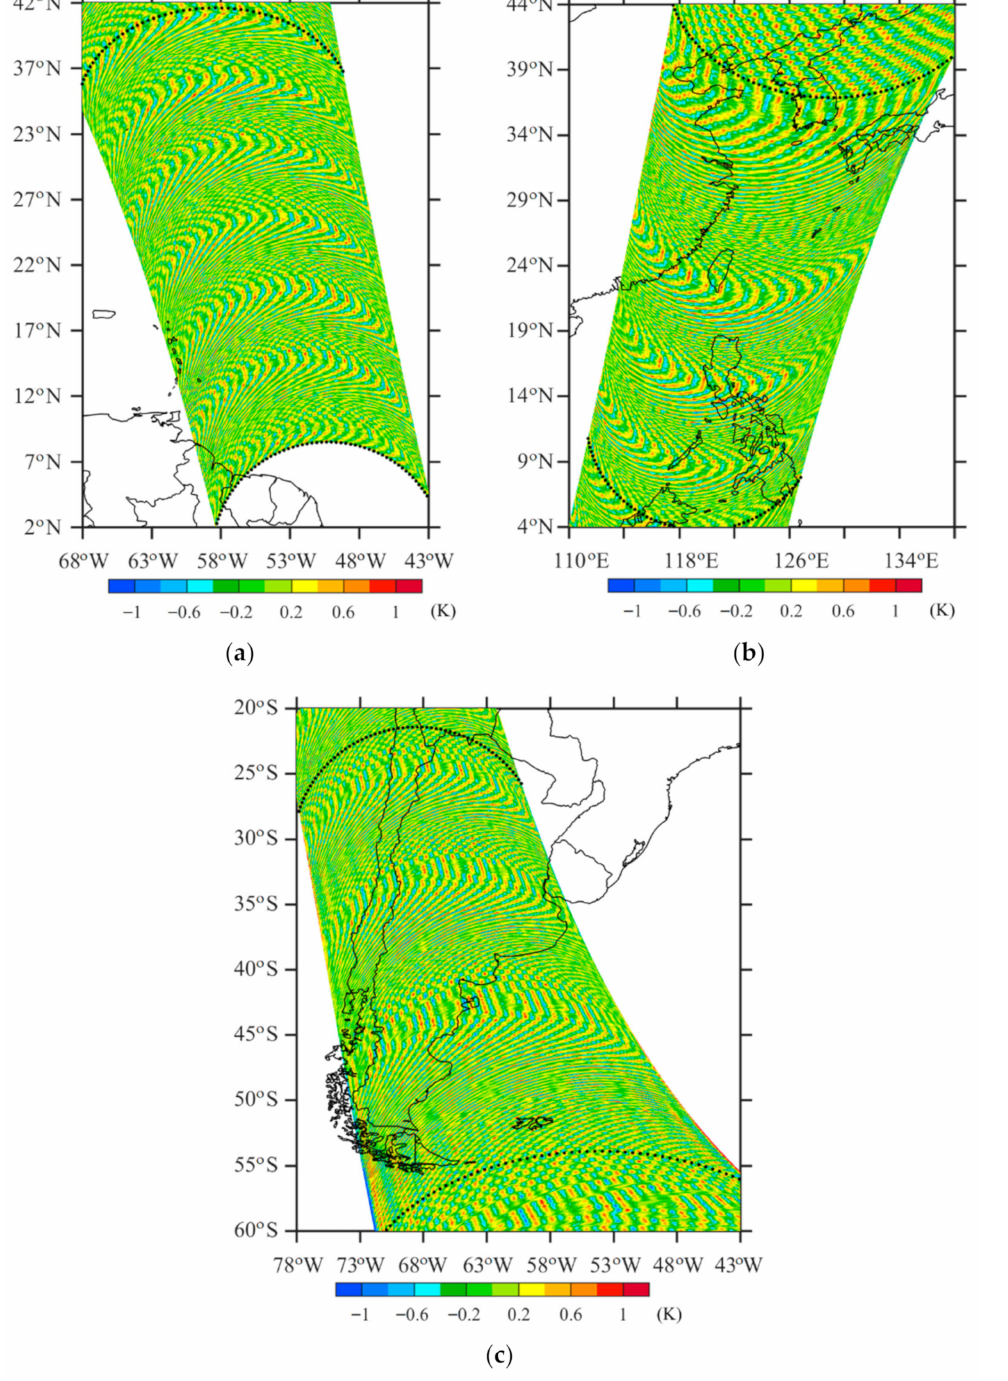
Figure 7. The noise extracted from TB observations of channel 5 on 5 September 2017 in areas ( a ) A, ( b ) B, and ( c )